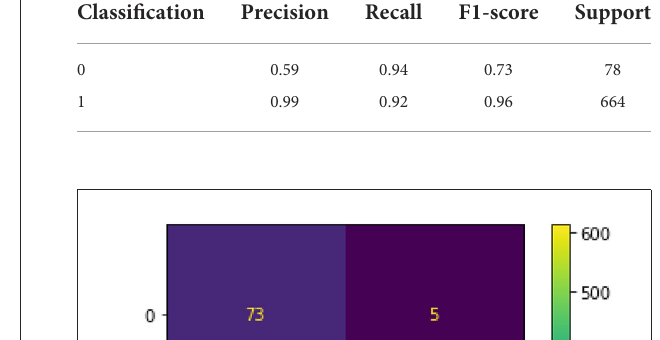
FIGURE3 ROC Curve for XGBoost model.